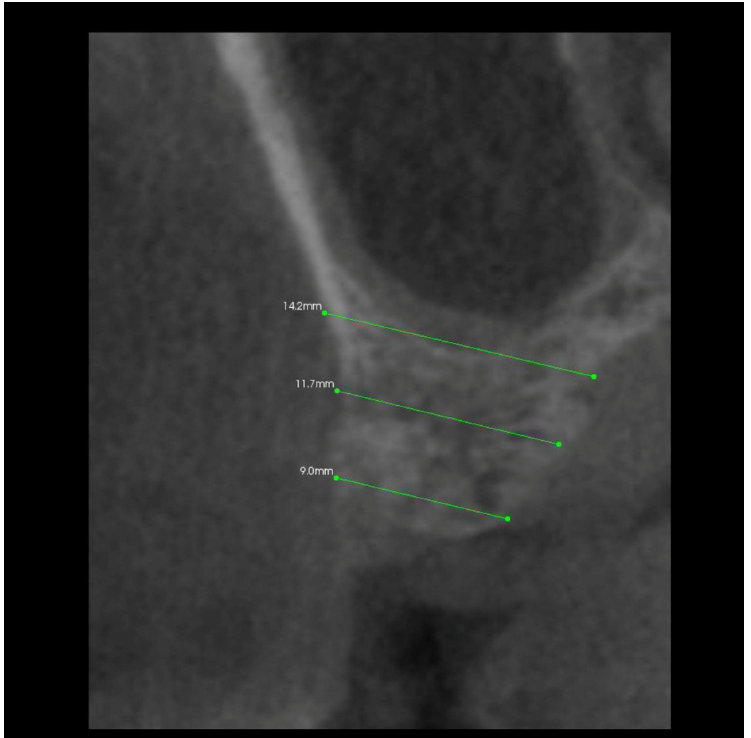
Figure 6. Transverse imaging of maxillary alveolus in CBCT. Alveolar width measurement 6 months post-extraction.